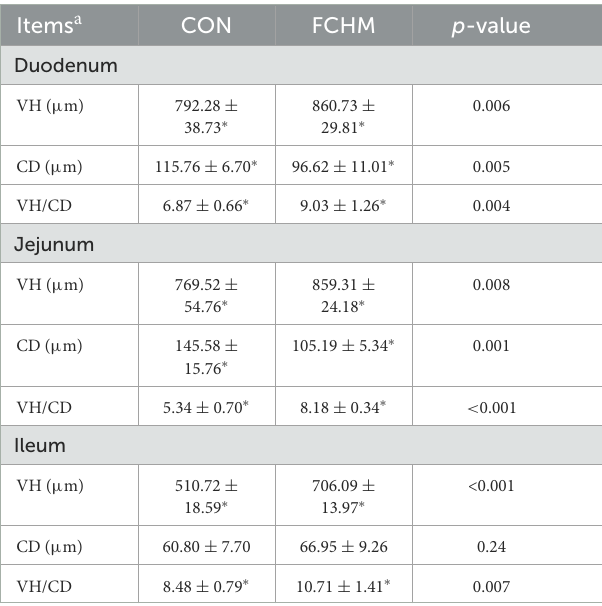
TABLE 7 Effects of FCHM supplementation on gut morphology of